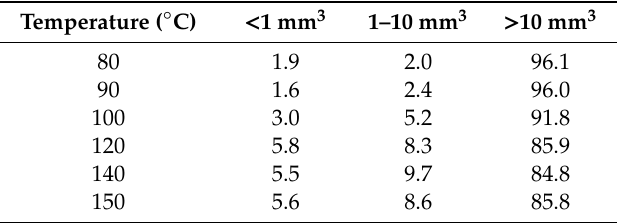
Table 10. Volume proportion of voids in asphalt mixtures